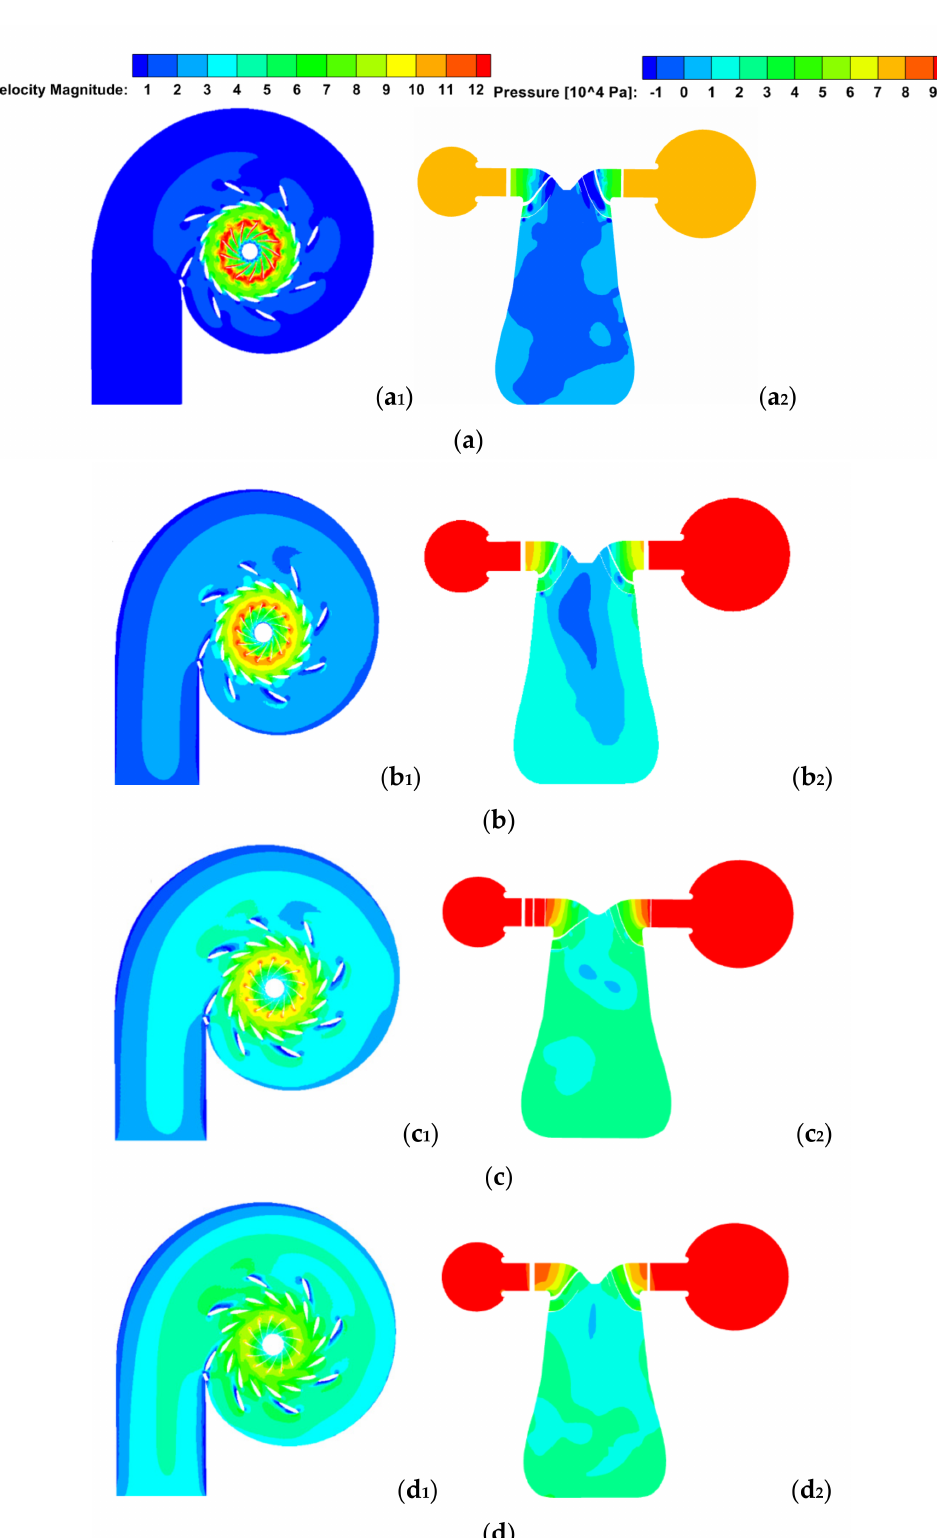
Figure 7. Guide apparatus of instantaneous velocity and means pressure. ( a ) α = 13.50 mm (small opening condition): ( a 1 ) Velocity contour plot (m/s), ( a 2 ) Pressure contour plot (Pa); ( b ) α = 26.17 mm: ( b 1 ) Velocity contour plot (m/s), ( b 2 ) Pressure contour plot (Pa); ( c ) α = 38.05 mm: ( c 1 ) Velocity contour plot (m/s), ( c 2 ) Pressure contour plot (Pa); ( d ) α = 48.74 mm (optimal condition): ( d 1 ) Velocity contour plot (m/s), ( d 2 ) Pressure contour plot